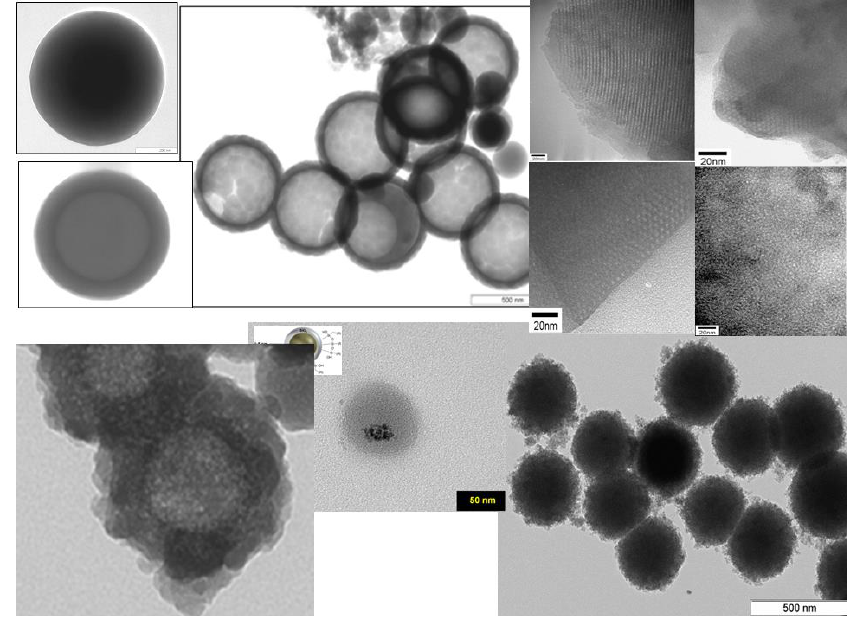
Figure 10. Examples of sol-gel NPs core-shells possibilities (from left-to-right, up-to-bottom): hollow-spheres (core, core-shell and hollow sphere); nanostructure mesoporous spheres; LIPOSIL structure; SPION-core-silica-shell and ORMOSIL NPs.